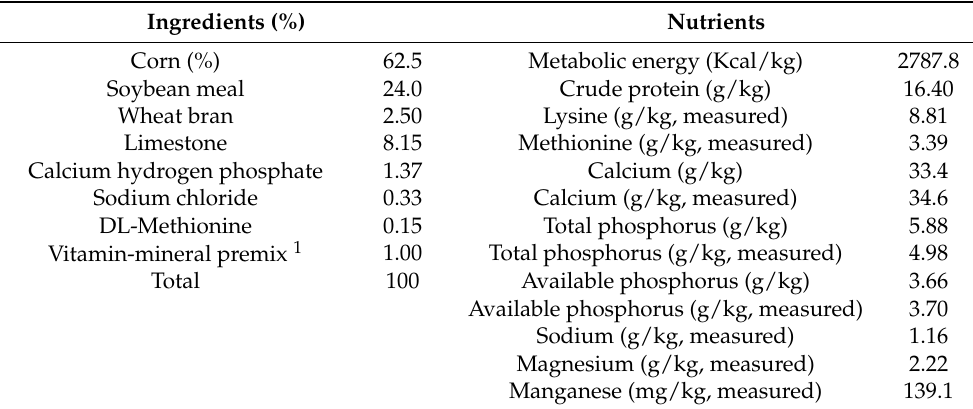
Table 1. Ingredients and nutrient levels of laying hen